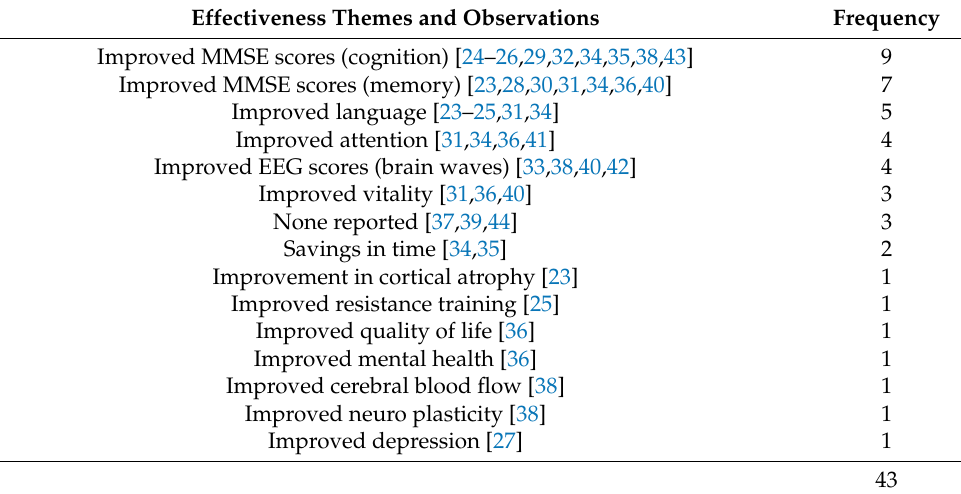
Table 5. Effectiveness of mHealth and VR for memory care for patients with